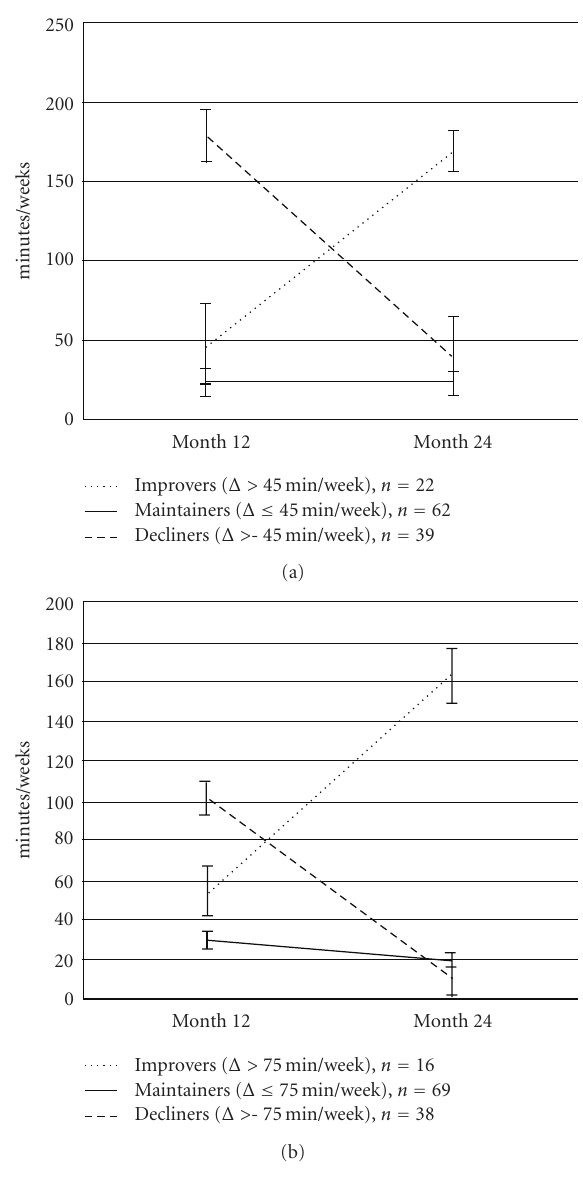
Figure 1: (a) Trajectories of post-intervention changes in minutes of moderate-intensity endurance PA. (b) Trajectories of post- interventionChangesin Minutes of Moderate-Intensity Strength PA ( Note that values represent means and standard